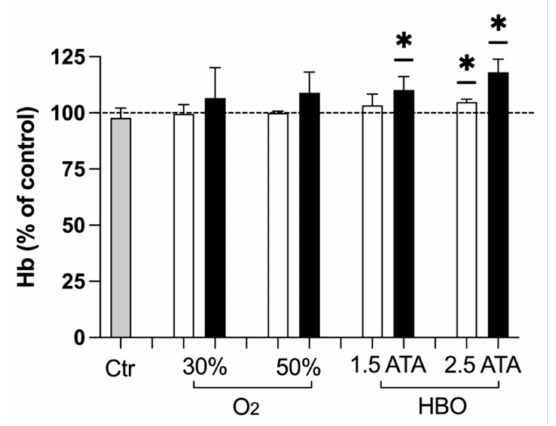
Figure 6. Histogram plot (% ± SD) of red blood cells hemoglobin (Hb). The control group (Ctr) is reported in grey; white and black bars identify T1 and T2, respectively. Significant difference intra- group: * p < 0.05. Significantly higher Hb concentration was detected at T2 with both HBO